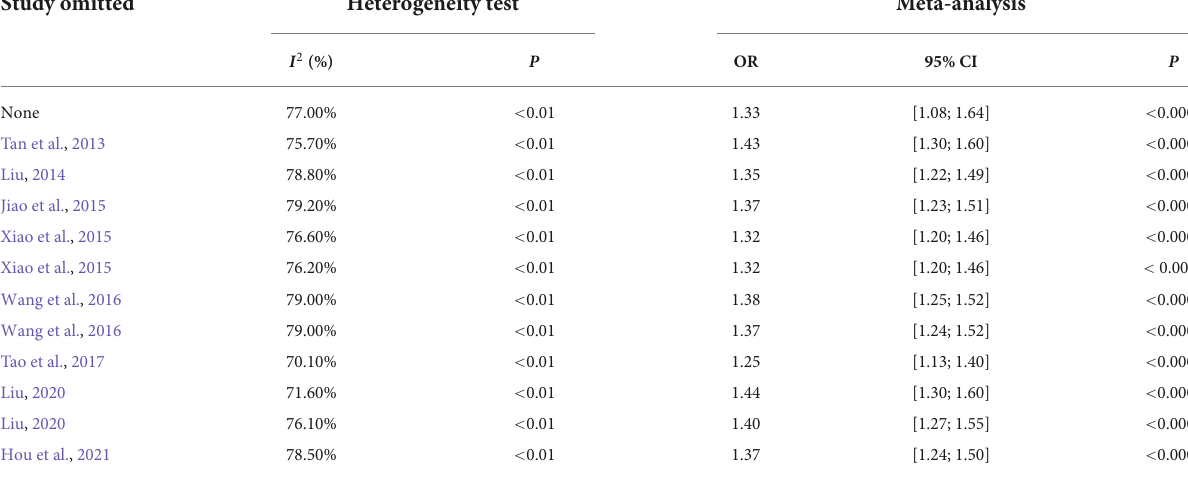
TABLE 2 Sensitivity analysis with each study omitted in the